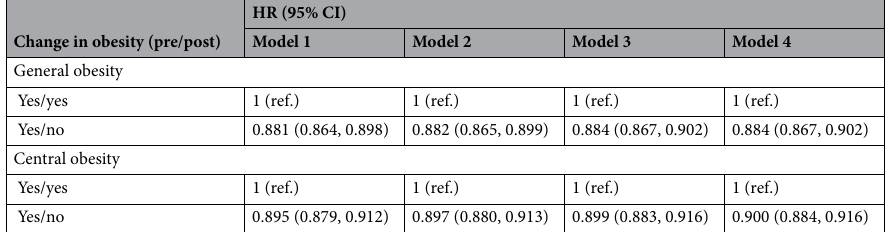
Change in obesity